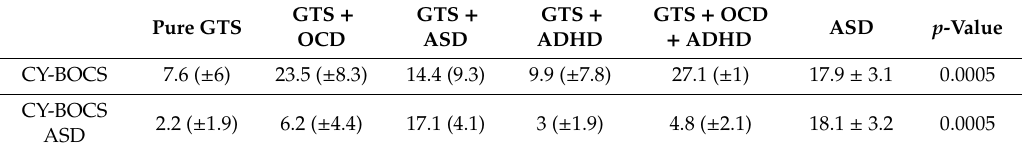
Table 3. Comparison between mean values of measures in each sub-phenotype and statistical significance.